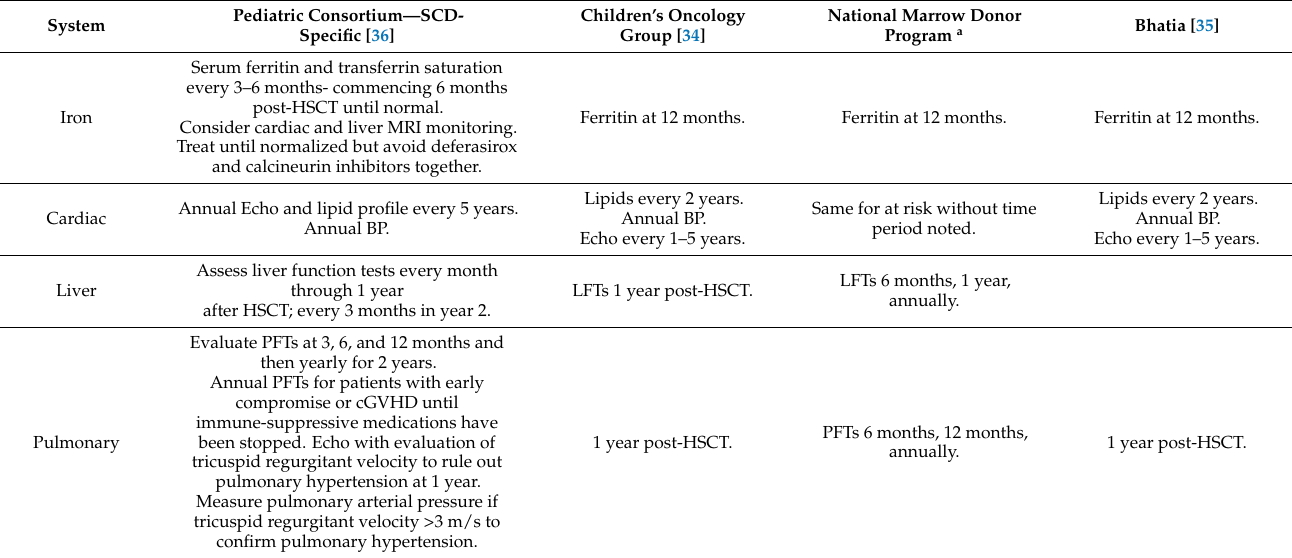
Table 1. Existing long-term follow-up guidelines for organ function monitoring after